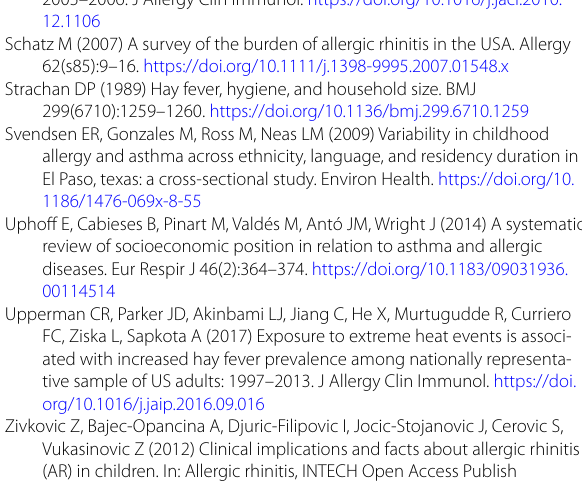
Table A-2. Selected respiratory diseases among adults aged 18 and over, by selected characteristics: United States, 2015. https:// ftp. cdc. gov/ pub/